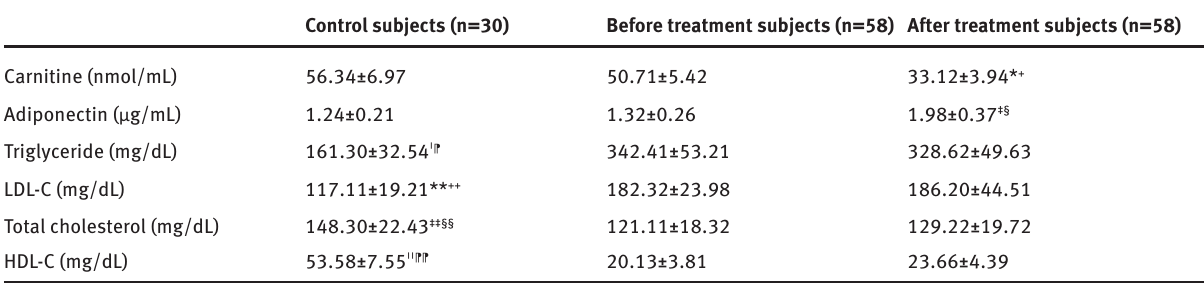
Table 2: Levels of serum carnitine, adiponectin and lipids in control and patients groups